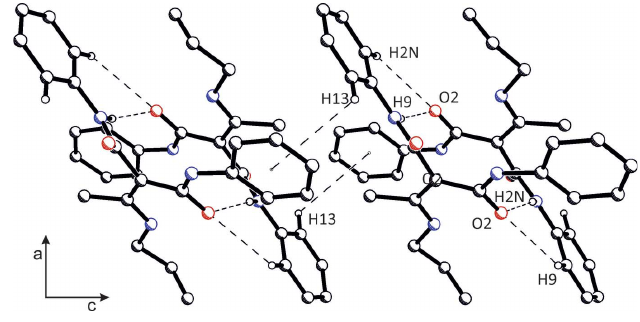
Figure 5 Packing diagram of polymorph ( II ) viewed along the b axis. Inter-